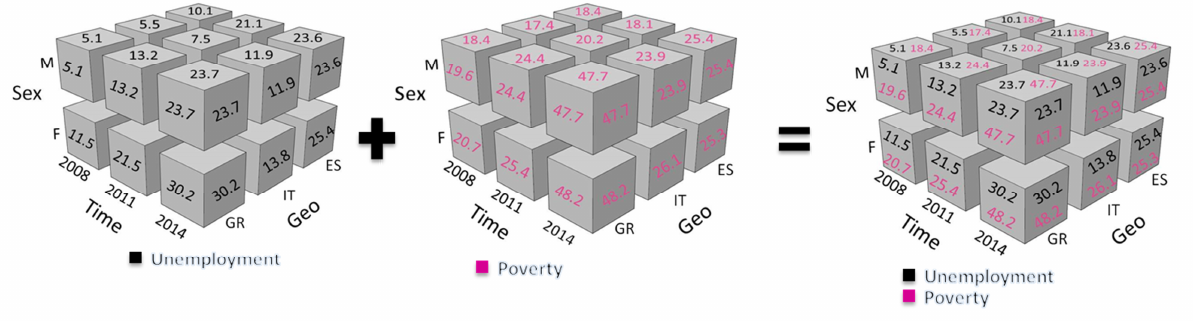
Another example is presented in figure 5 where two cubes with the same dimensions but with different measures (unemployment and poverty) are joined. The resulted cube contains two measures along the same dimensions. Figure 5: Expanding a Cube with Data from other